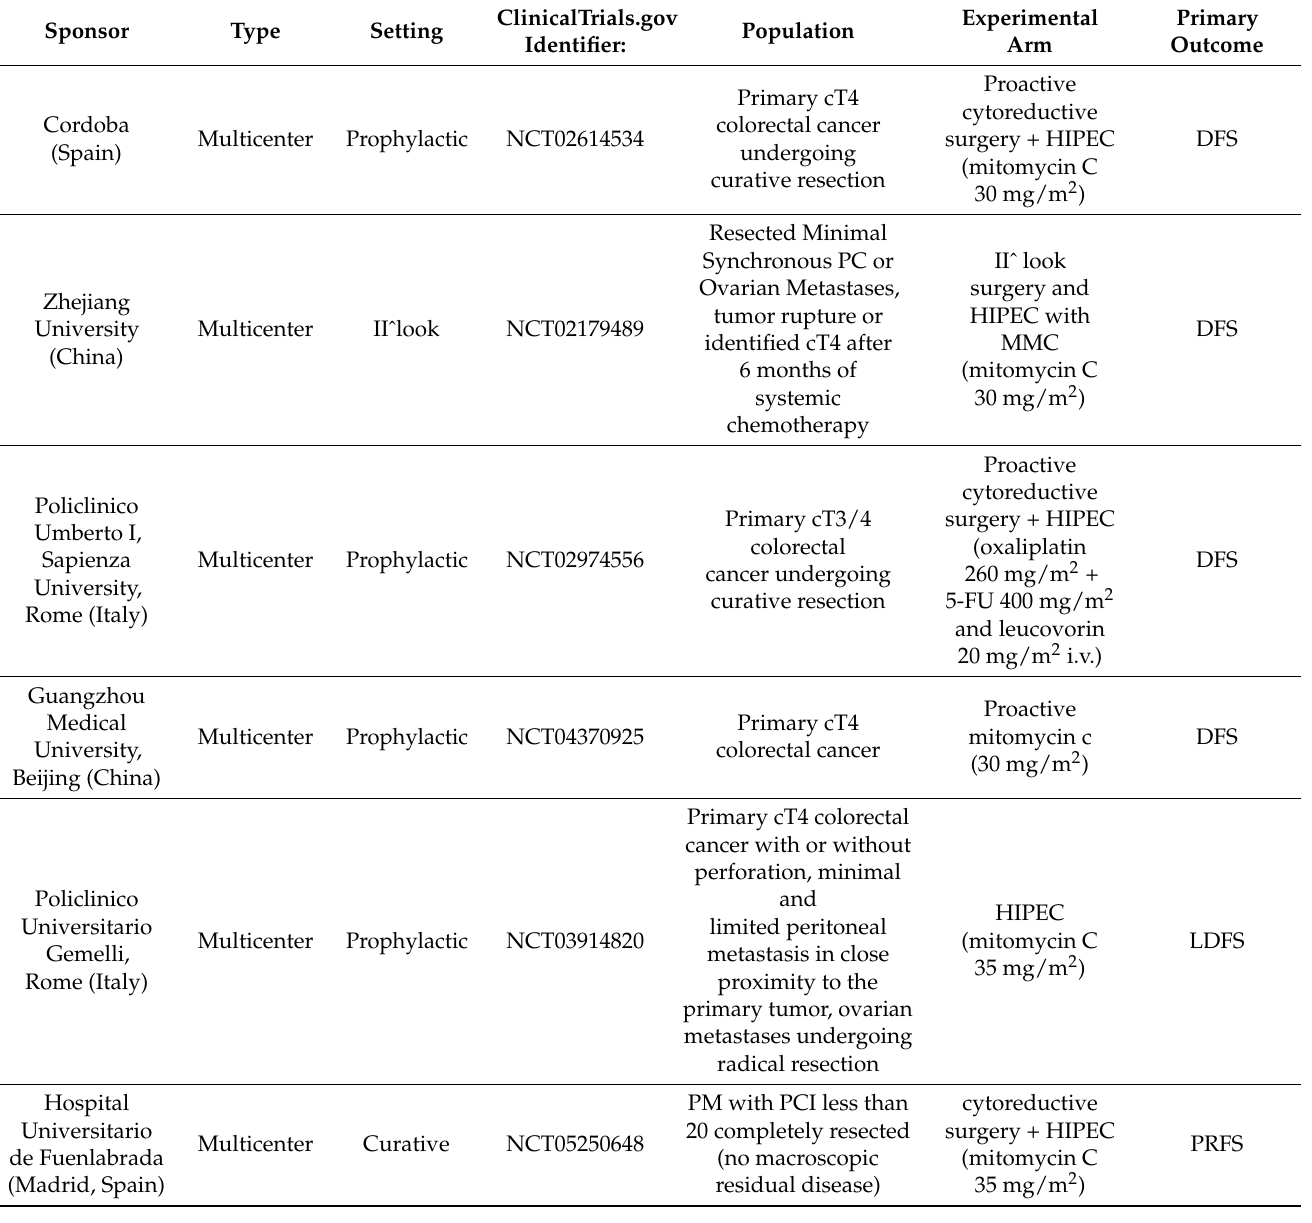
Table 2. Randomized controlled trials investigating prophylactic HIPEC/IIˆLook in CRC